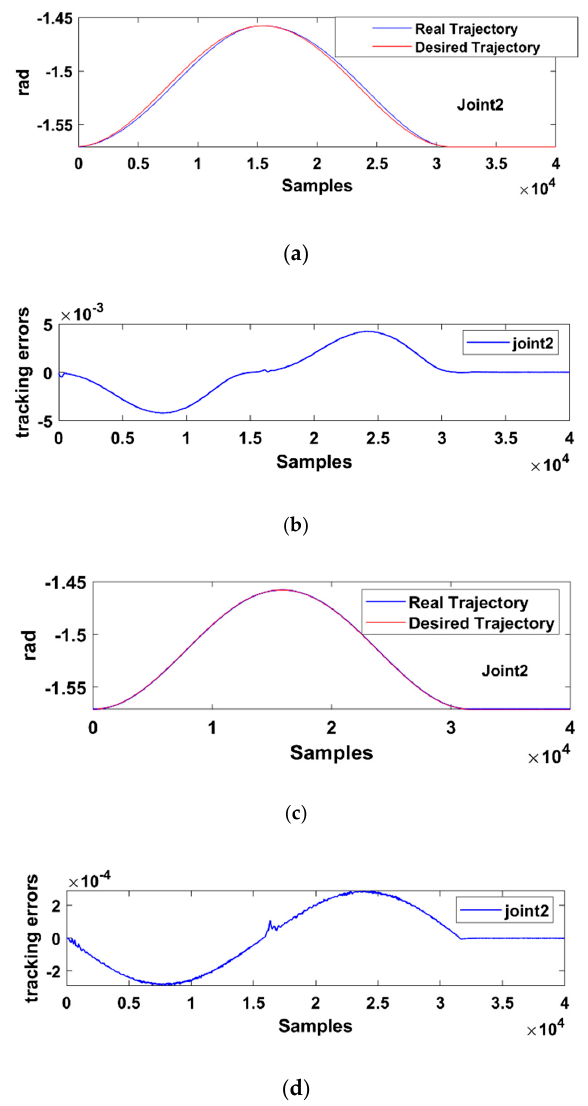
Figure 9. The trajectory follow-up results and error curve of joint 2 in different controllers (w = 2 rad/s). ( a ) trajectory follow-up curve of PI controller; ( b ) trajectory following errors of PI controller; ( c ) trajectory follow-up curve of ADRC controller; ( d ) trajectory following error of ADRC controller based on dynamic feedforward.